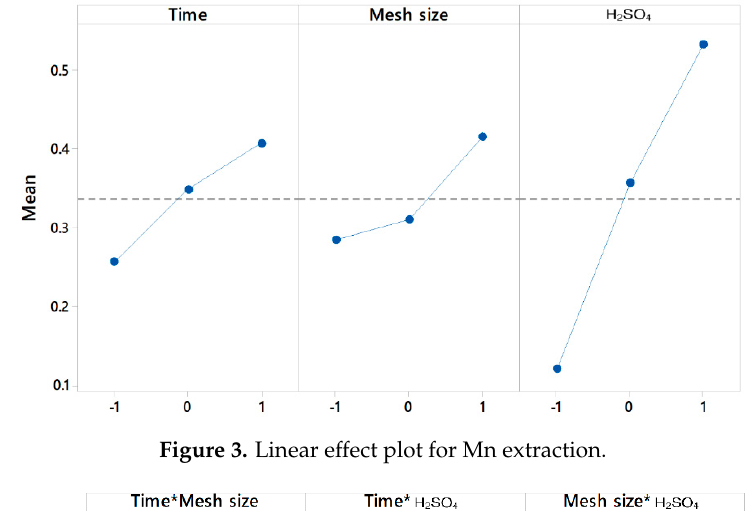
Figure 3. Linear effect plot for Mn extraction.